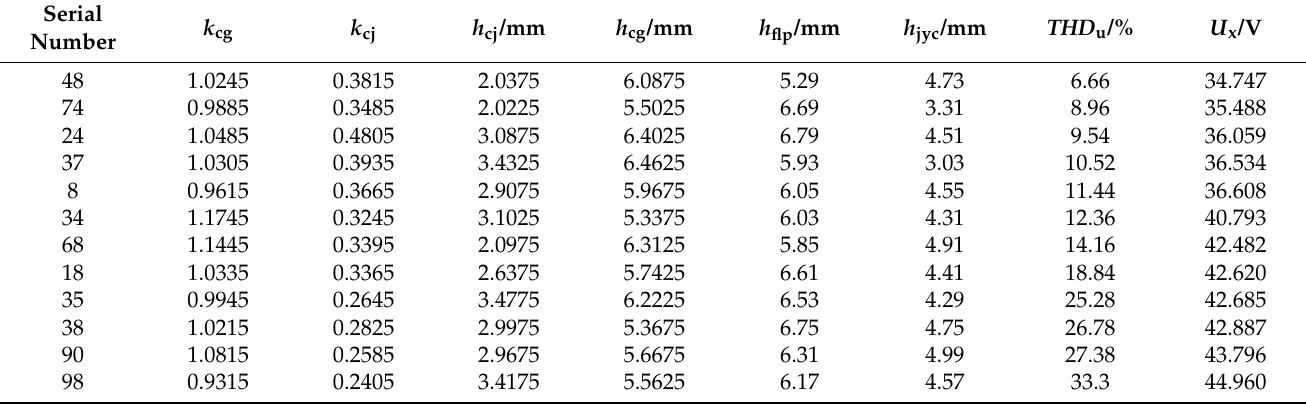
Table 3. The concrete values of design variables and optimization goals in valid